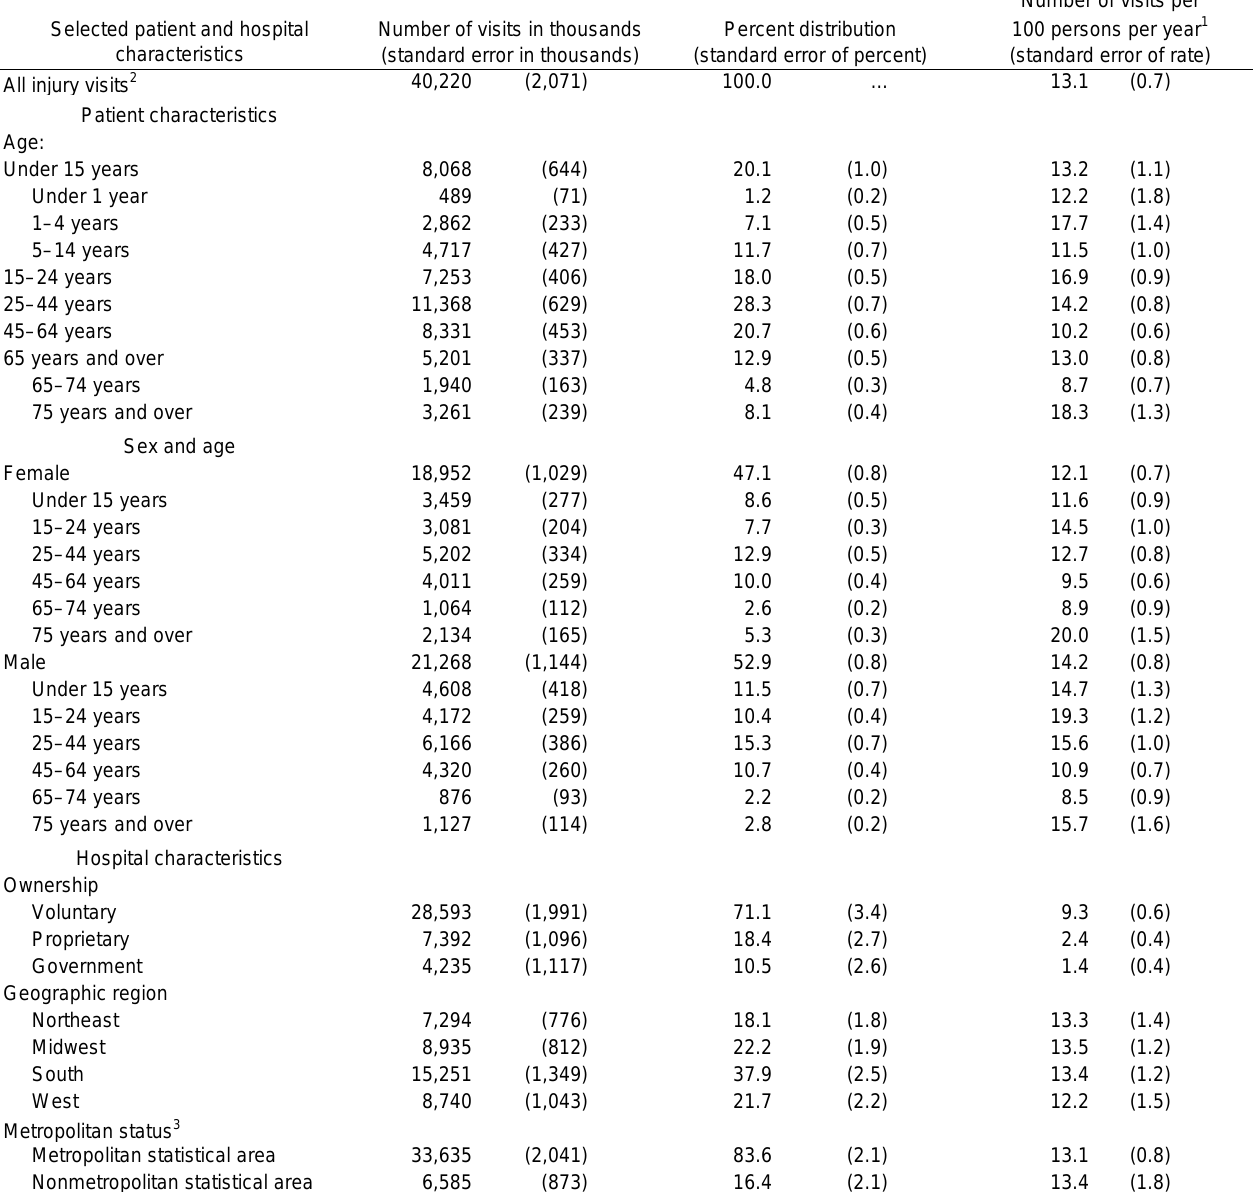
Table 14. Injury visits to emergency departments, by selected patient and hospital characteristics: United States,